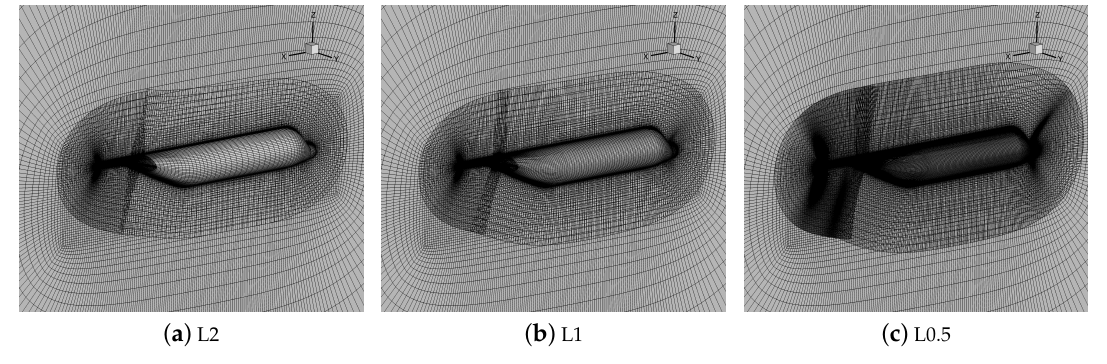
Figure 4. Different mesh level.